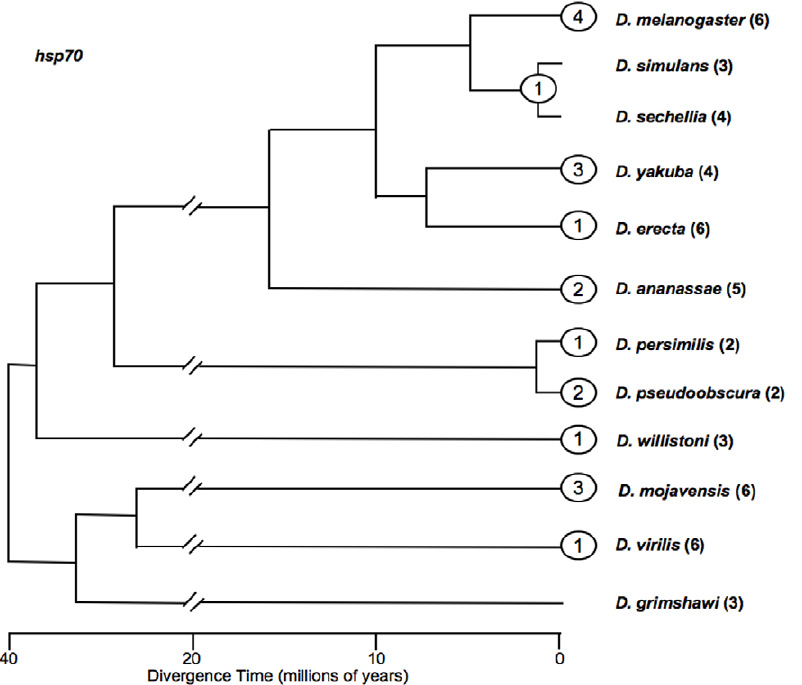
Figure 1. Phylogenetic distribution of transposable element insertions into promoter regions of Hsp70 in the 12 species of Drosophila that have undergone whole-genome sequencing. Each numbered oval represents transposable element insertions. The position of the oval corresponds to the species, species pair, or species group in which the insertion was detected. Ovals at tips are insertions restricted to single species, while ovals at nodes are found in all species emanating from that node. The horizontal scale indicates the time at which the species are presumed to have diverged [59] but is otherwise not pertinent to the time of the TE insertions. Double slashes represent a compression of the time scale at the base of the tree. Numbers following species names in parentheses indicate the number of copies of Hsp70 per